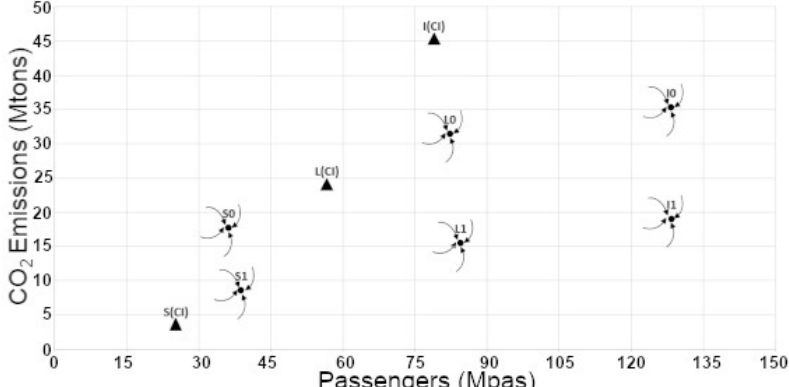
Figure 1. The position of the equilibrium points of the nonlinear model for β = 1.25, according to the different types of flight, are marked in the phase diagram by black circles. The points with lower emission values correspond to the cases S1, L1, and I1 while those with the higher emissions correspond to the cases S0, L0, and I0. The location of the initial conditions, which are labelled S(CI), L(CI), and I(CI), are marked by black triangles.